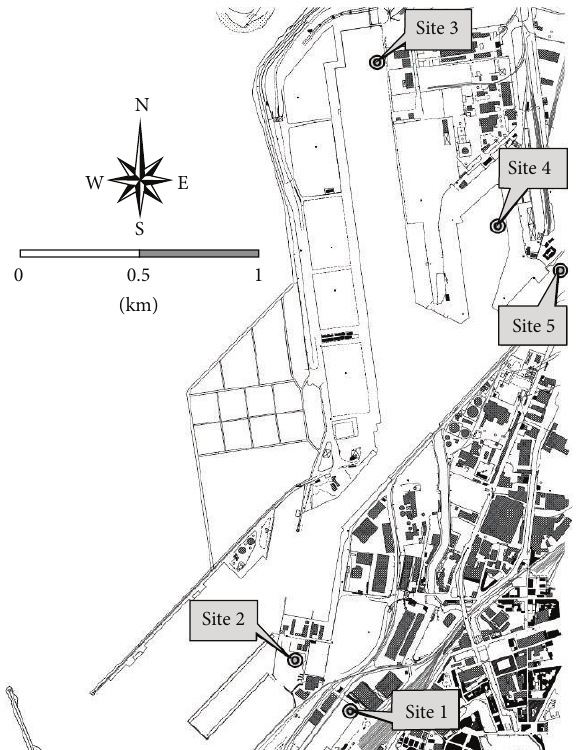
Figure 1: Representation of the Leghorn’s Harbor area. The tagged marks represent the sampling sites in the seabed of the area, which are briefly described as follows. Site 1: ferry boat departure area (sandy loam; water depth 11m). Site 2: seldom dredged shipbuilding area (loam; water depth 4 m; last dredging 60 years ago). Site 3: container terminal (silt loam; water depth 13m; located by the open sea mouth of the